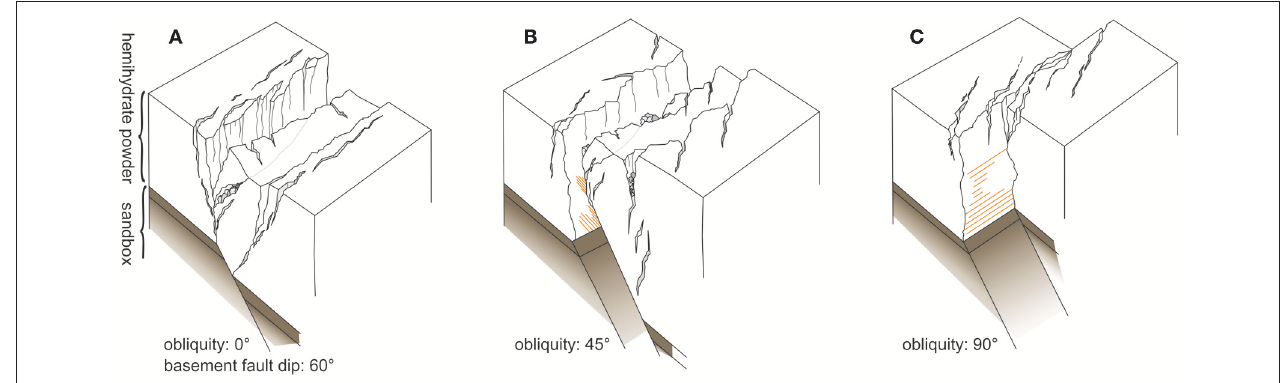
FIGURE 13 | Generic model of the observed structures depending on obliquity. (A) Dip slip deformation. A graben develops and tilted blocks form. Dilatancy is large close to the surface and decreases with depth. Fractures strike roughly parallel to the basement fault. In the graben, fractures perpendicular to the fault form occasionally. Sinuosity of the main fault is low. Open fractures are connected along the entire fault. (B) Oblique slip deformation. Graben is less wide, and tilted blocks are smaller. Sinuosity is high and influenced by early en-échelon fractures. Dilatancy occurs close to the surface and at depth. Red lines show slickensides on the fault